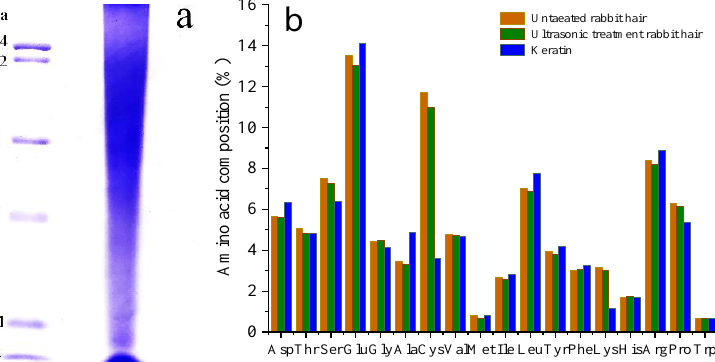
Figure 2. ( a ) SDS-PAGE of extracted rabbit hair keratin, ( b ) Amino acid composition (mole%).